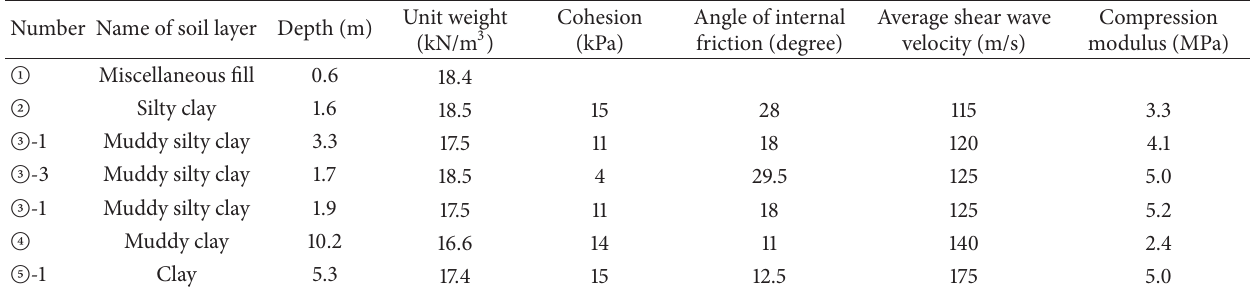
Table 6: Soil characteristics parameter.